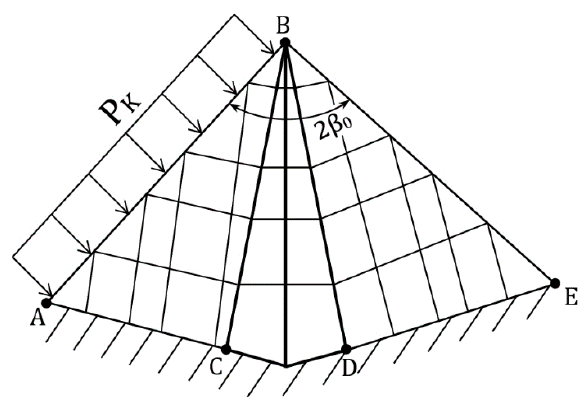
Fig. 3. Grid of slip curves, when β 0 ≤ π/2.